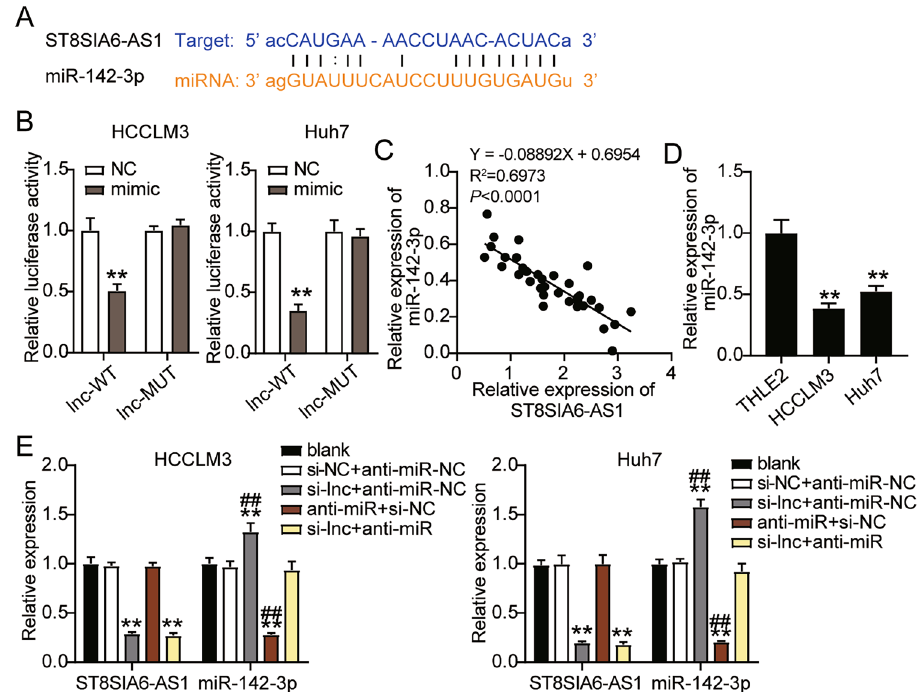
Figure 5. ST8SIA6-AS1 sponged miR-142-3p in LIHC cells. ( A ) StarBase analysis prediction for binding sites between miR-142-3p and ST8SIA6-AS1. ( B ) Performance of Dual luciferase assessment in HCCLM3 and Huh7 cells. **P < 0.001 compared with NC. ( C ) The expression of miR-142-3p and ST8SIA6 AS1 are negatively correlated. ( D ) In LIHC cells (HCCLM3 and Huh7 cells), the expression of miR-142-3p was downregulate compared to normal cells (THLE2). **P < 0.001 compared with THLE2. ( E ) In HCCLM3 and Huh7 cells, miR- 142-3p and ST8SIA6-AS1 expression was measured by RT-qPCR. ## P < 0.001 compared with si-lnc + anti-miR; **P < 0.001 compared with blank. WT: wild-type; Si-lnc: SiRNA-ST8SIA6-AS1, MUT: Mutant; anti-miR: miR- 142-3p inhibitor, NC: negative control, and blank: blank control, Si-lnc + anti-miR (SiRNA-ST8SIA6-AS1 + miR- 142-3p